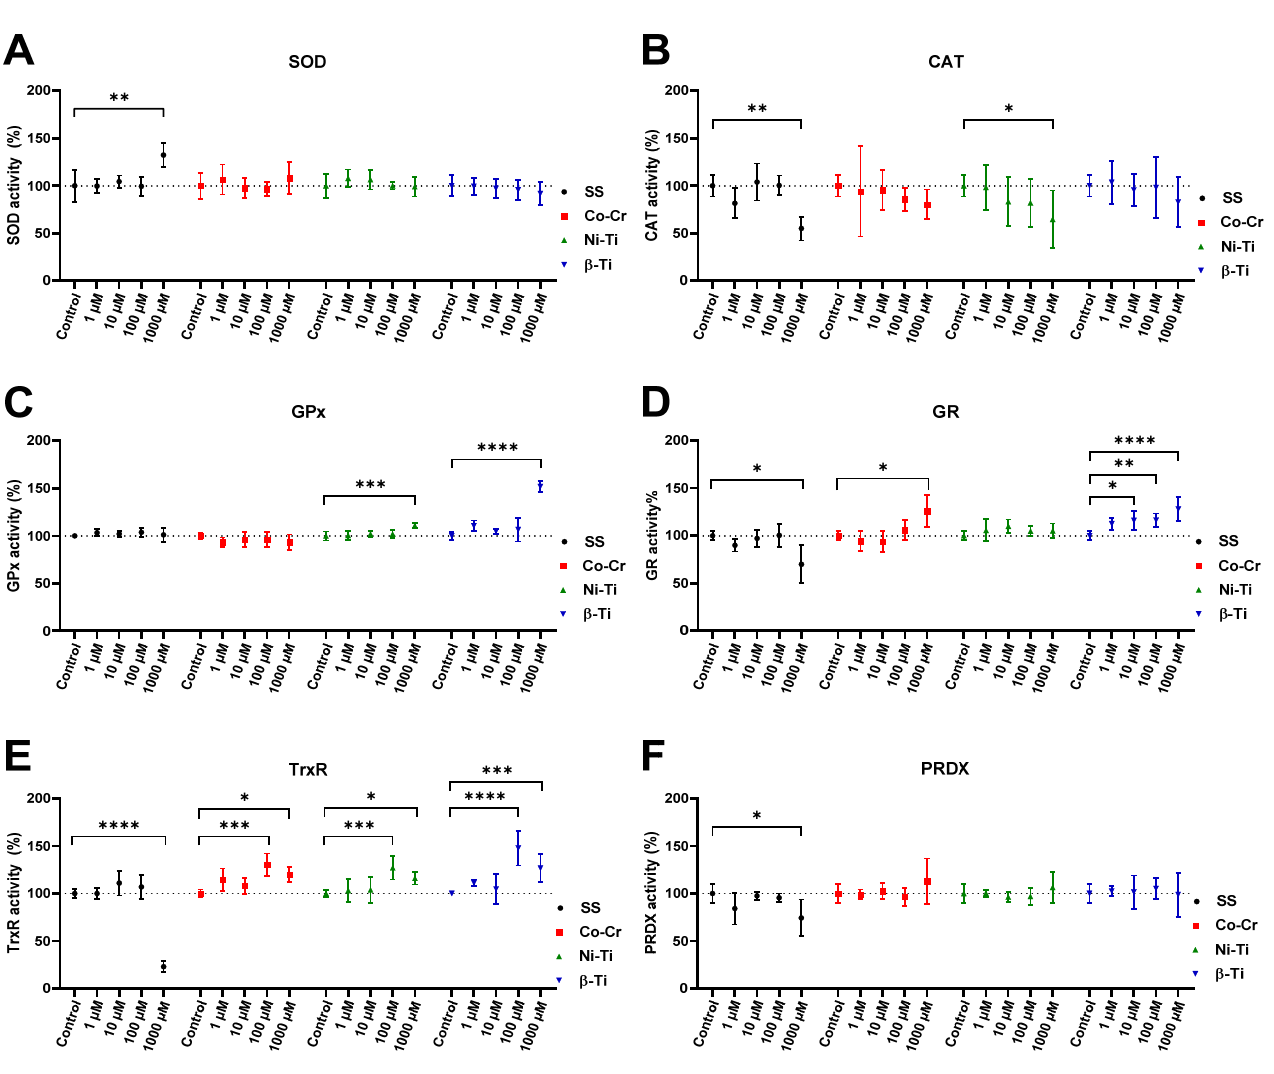
Figure 4. Change in antioxidant enzyme activities when yeast cells are treated with increasing concentrations of different metal ion mixtures, compared to the untreated control. Graph ( A ) shows SOD, ( B ) shows CAT, ( C ) shows GPx, ( D ) shows GR, ( E ) shows TrxR, and ( F ) shows PRDX activity. The untreated sample was set at 100%, and the means with 95% confi- dent interval are shown. Statistically different results are labeled with * (* p < 0.05, ** p < 0.01, *** p < 0.001, and **** p <